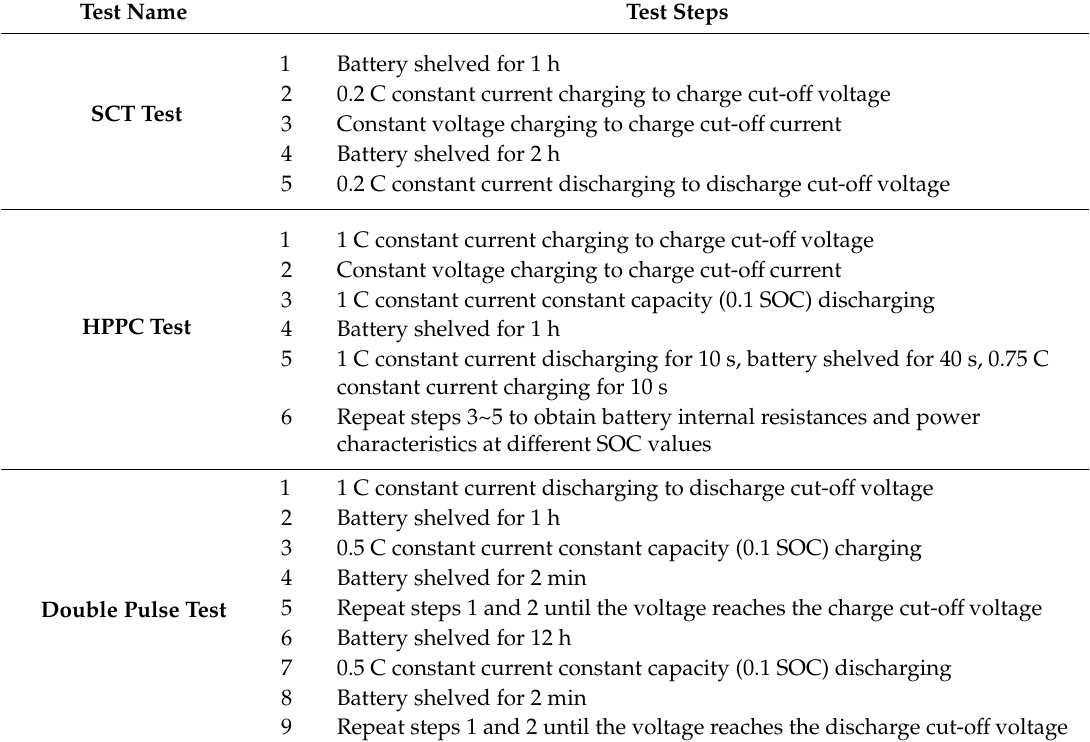
Table 2. Major test steps of the static capacity test (SCT), hybrid pulse power characteristic (HPPC), and double pulse tests.